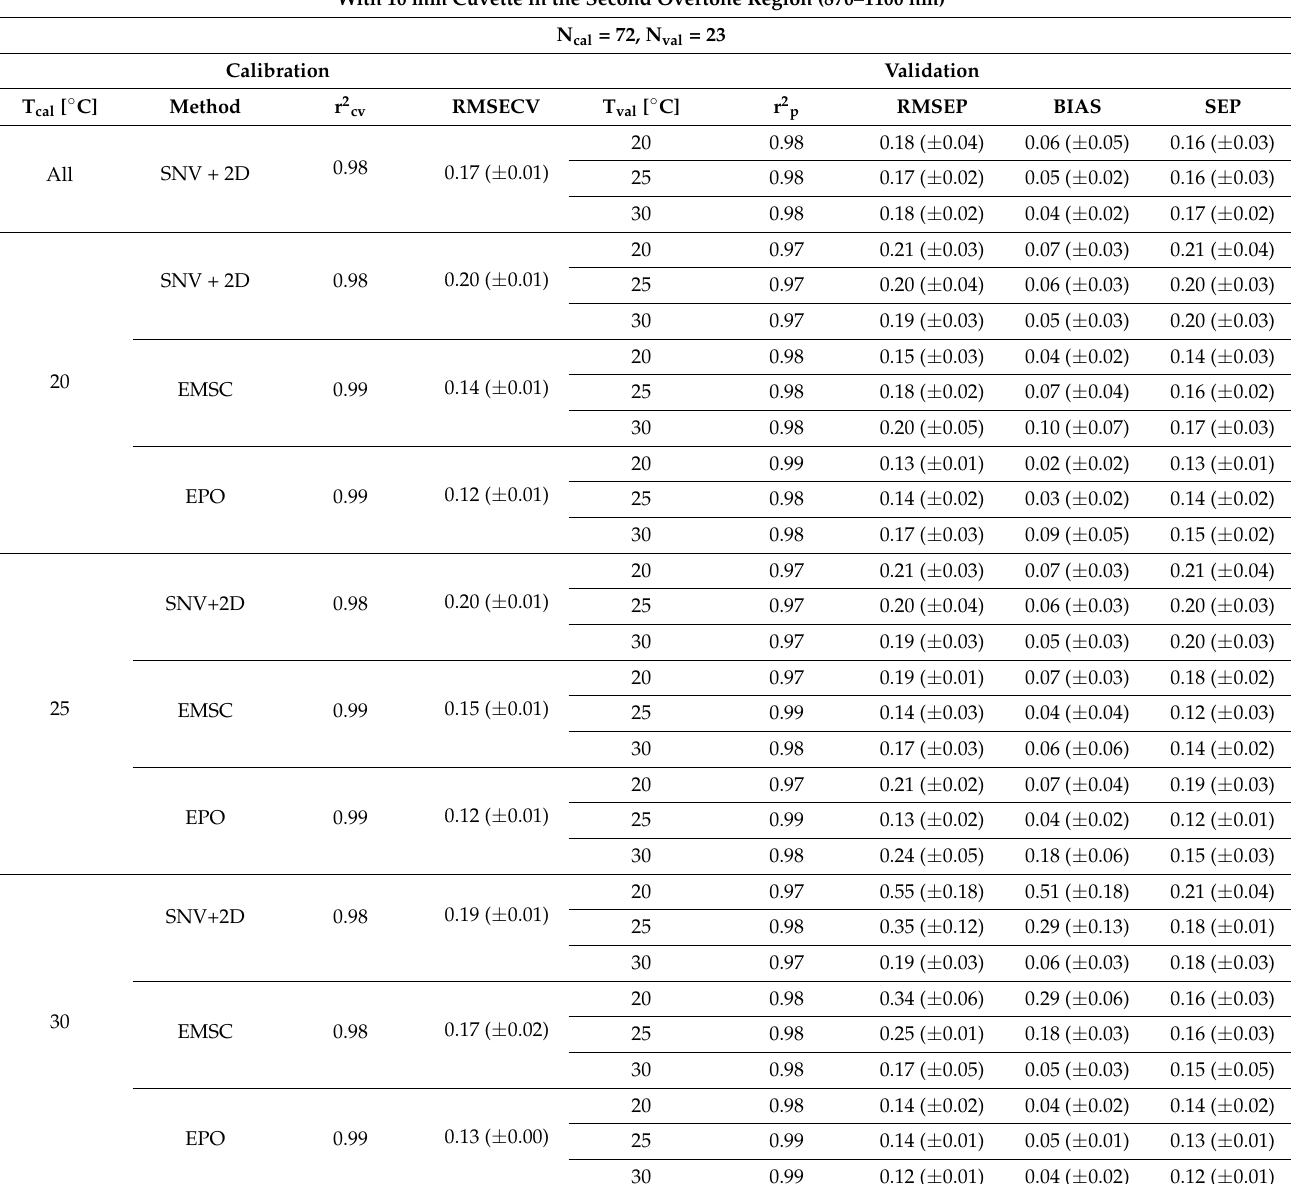
Table 3. Performance comparison for SSC prediction of kiwifruit juice in the first overtone (870–1100 nm) region of the OH stretch of water at different